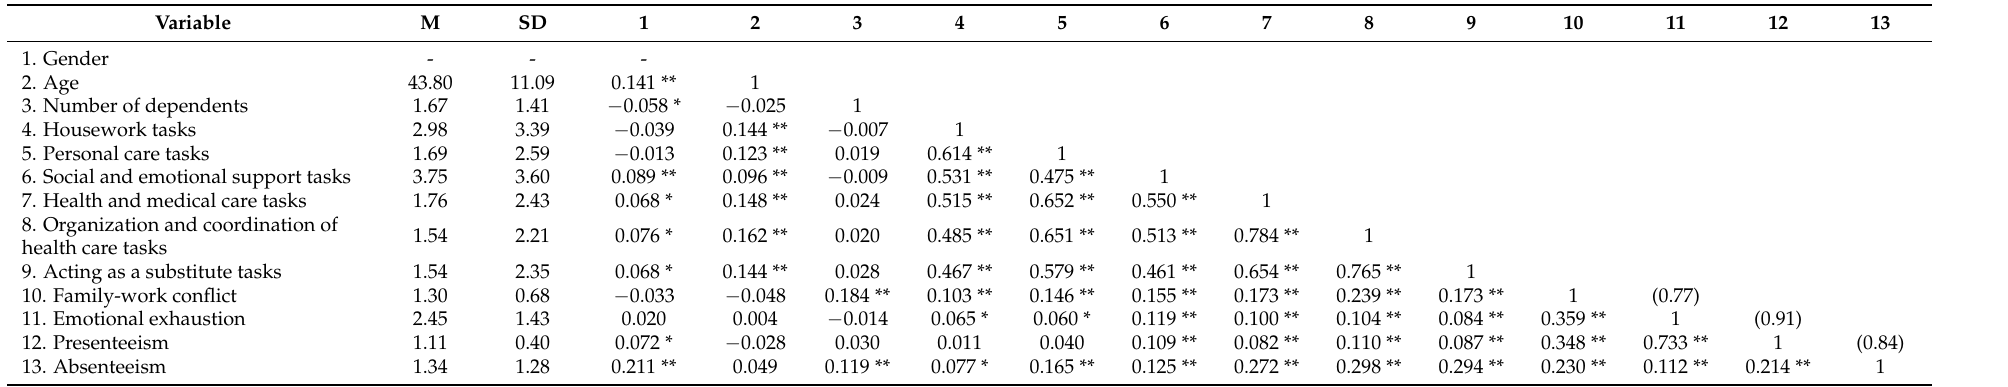
Table 2. Descriptive statistics and correlation